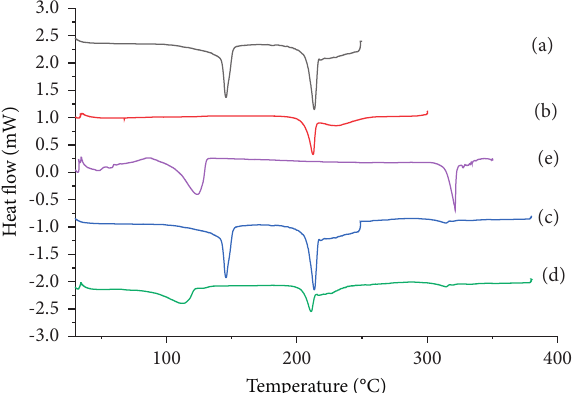
Figure 5: DSC spectra of (A) α -lactose monohydrate, (B) porous lactose, (C) quercetin, (D) porous lactose particles after quercetin loading, and (E) α -lactose monohydrate after quercetin loading.